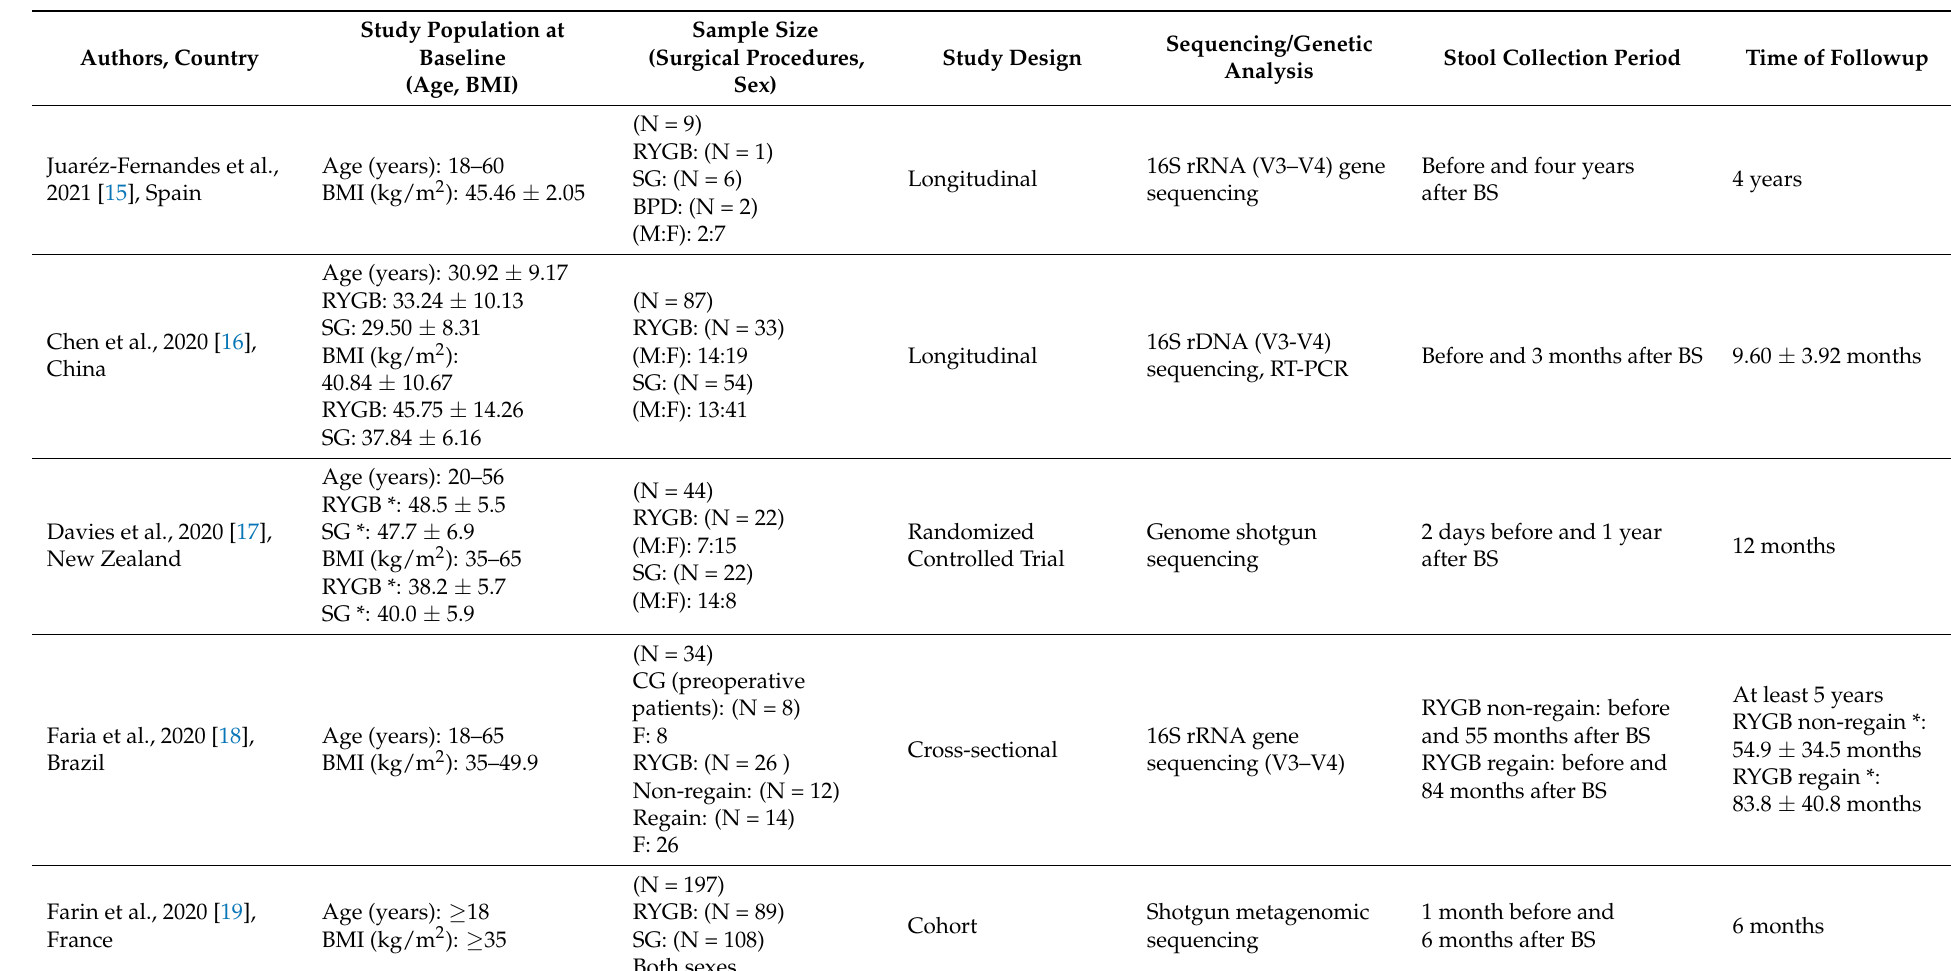
Table 2. Summary of reviewed